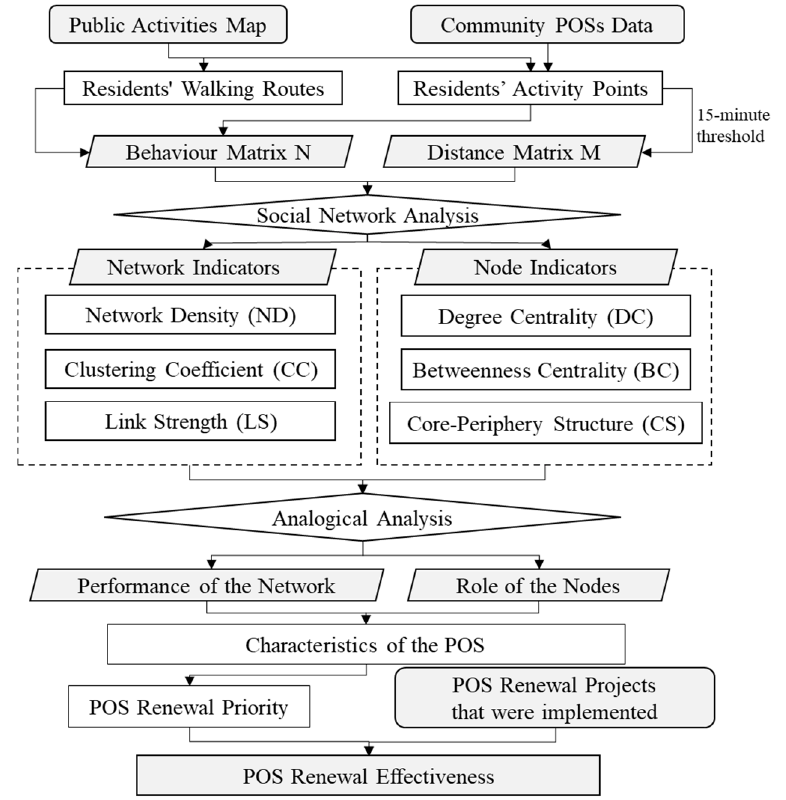
Figure 1. Research framework.